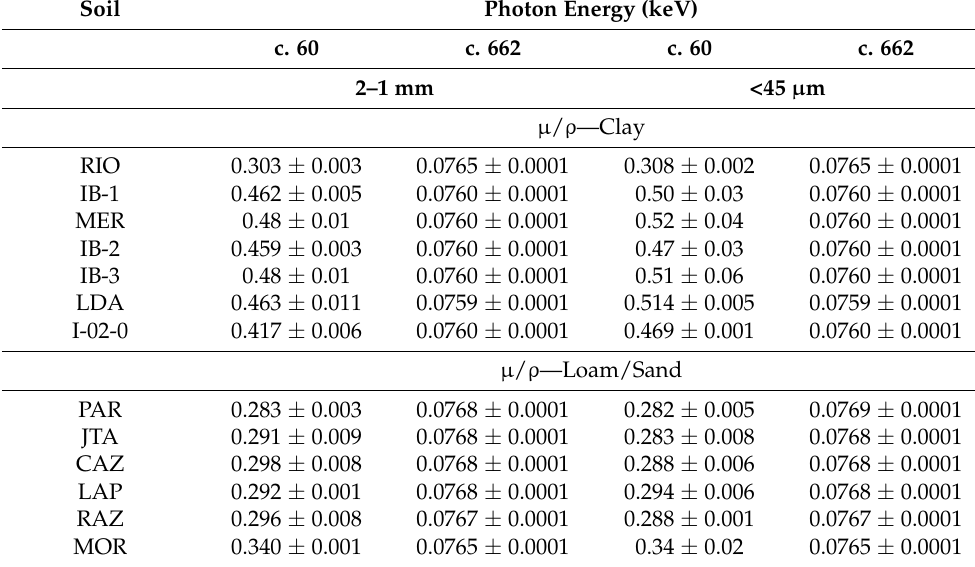
Table 3. Mass attenuation coefficient ( µ / ρ ) for the photon energies of c. 60 and c. 662 keV of the 13 soil types studied presenting different aggregate sizes (2–1 mm and <45 µ m). The average values are followed by the standard deviation, which was rounded according to significant figures. Soil Photon Energy (keV) c. 60 c. 662 c. 60 c. 662 2–1